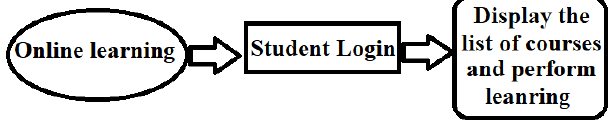
Figure 7. Access to learn online platforms.